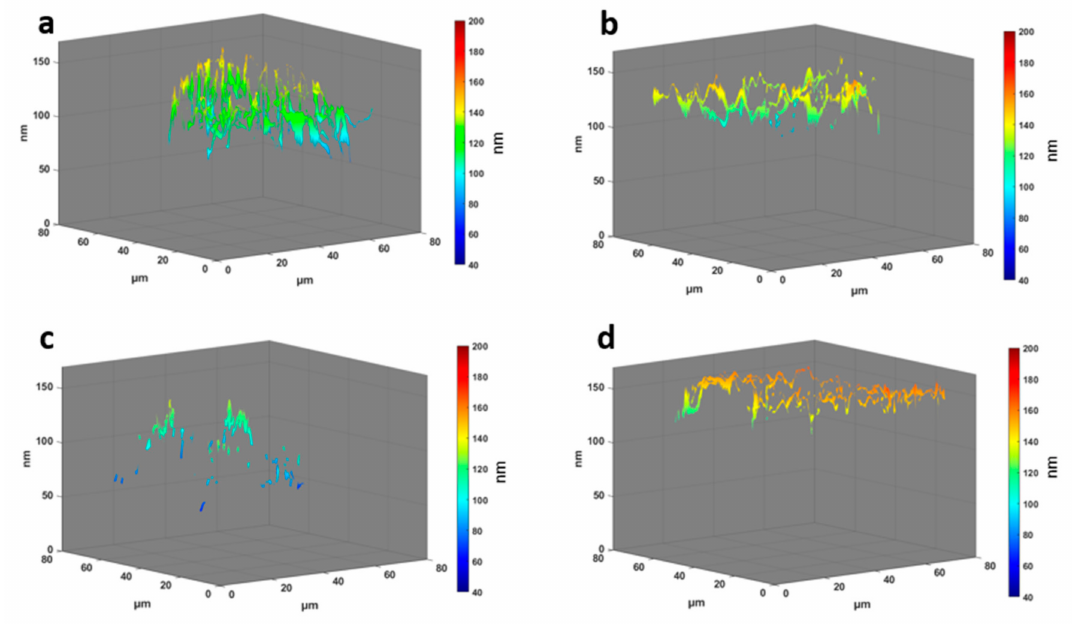
Figure 4. 3D plots of the actin distribution with height information in z dimension. The arrow represents the polarization of the cell. The cells shown are the cells from Figure 2 and representative of their population. ( a ) Untreated cells. ( b ) Blebbistatin-treated cells. ( c ) Y27632 treated cells. ( d ) Rho activator-treated